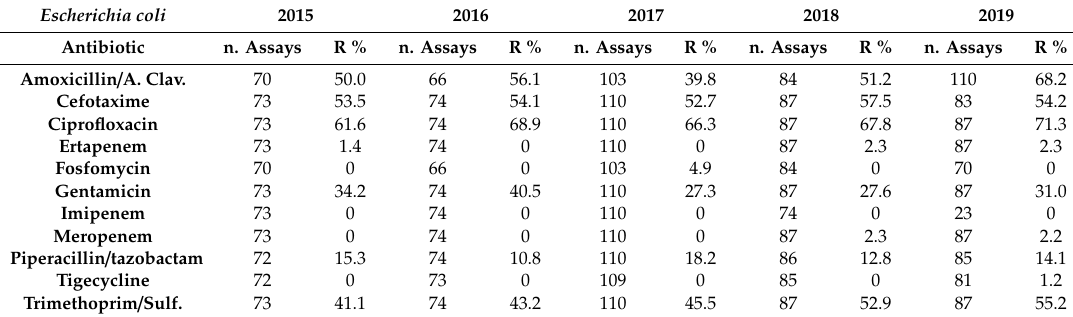
Table 5. Antimicrobial resistance profile of Escherichia coli from patients with BSI to commonly used